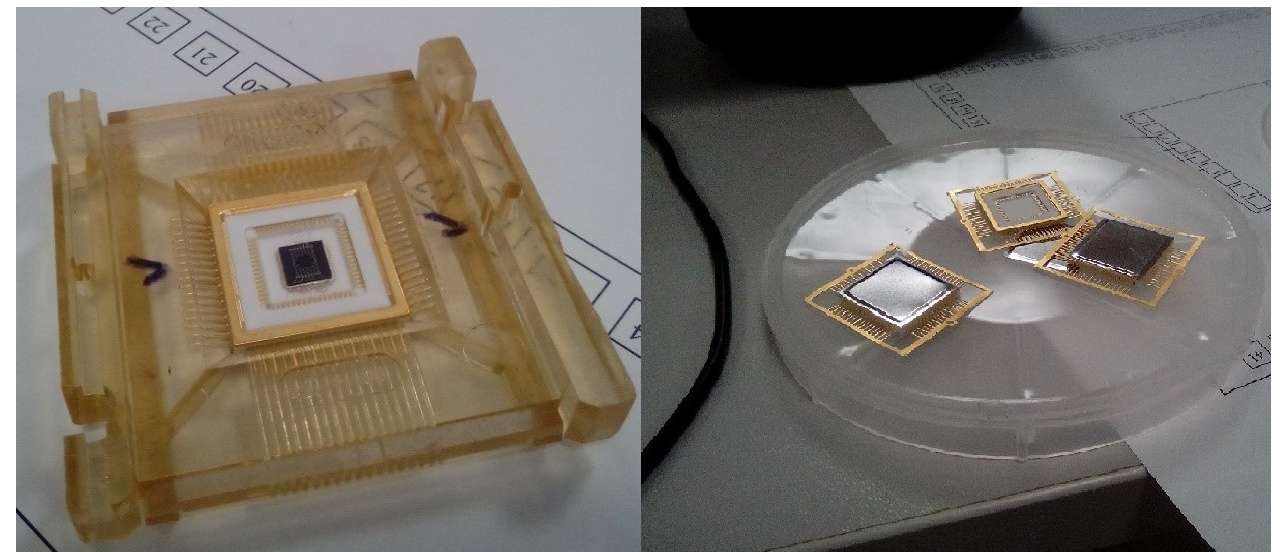
Figure 32. The studied prototype of the SE of the MEMS gyroscope on the measuring